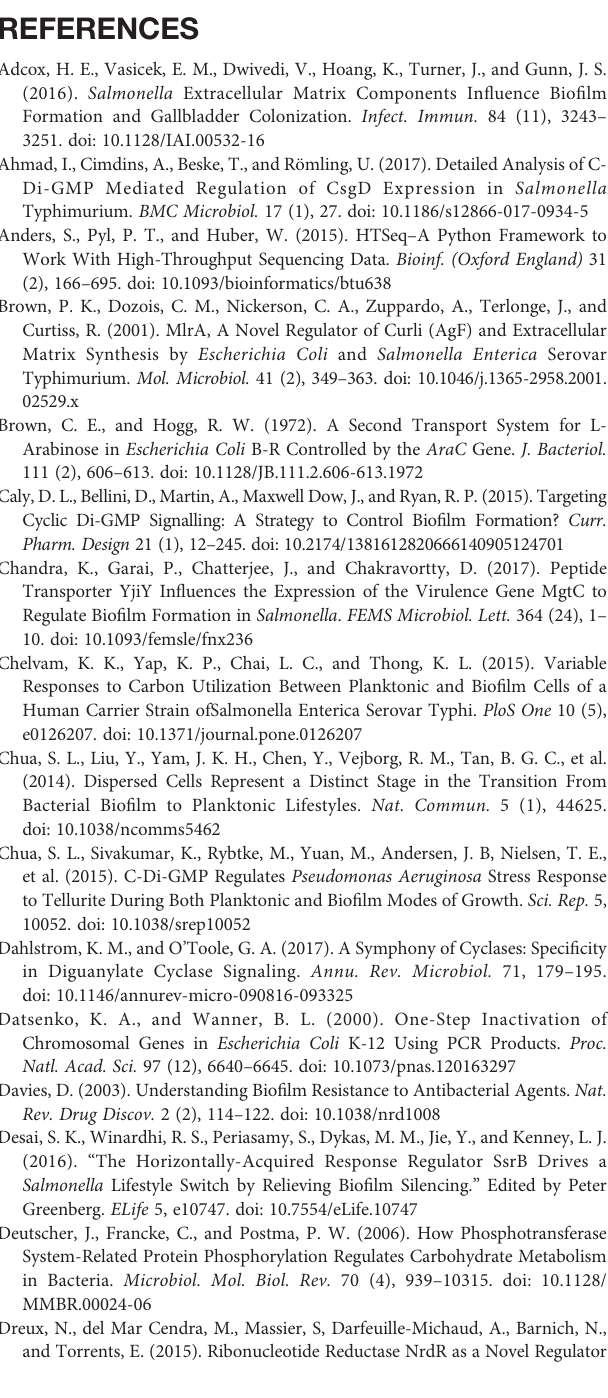
Supplementary Figure 3 | YcfR and CyaA are not involved in L-arabinose hyperbio fi lm formation. (A) WT 14028, D araE , D ycfR , and strains containing ycfR constitutively expressed on a plasmid were grown in 96-well plates in 100 µL 1:20 TSB(blackbars)or1:20TSBwith0.2%(whitebars).After24hours,planktoniccells wereremoved,thenbio fi lms werewashed,heat fi xed, andstained withcrystal violet (CV) for relative bio fi lm measurement as determined at OD 570 . (B) WT 14028, D araE , and strain containing cyaA constitutively expressed on a plasmid. Data are mean ± SD, statistical analyses were done using a two-way ANOVA with Dunnett ’ s multiple comparisons test **** P